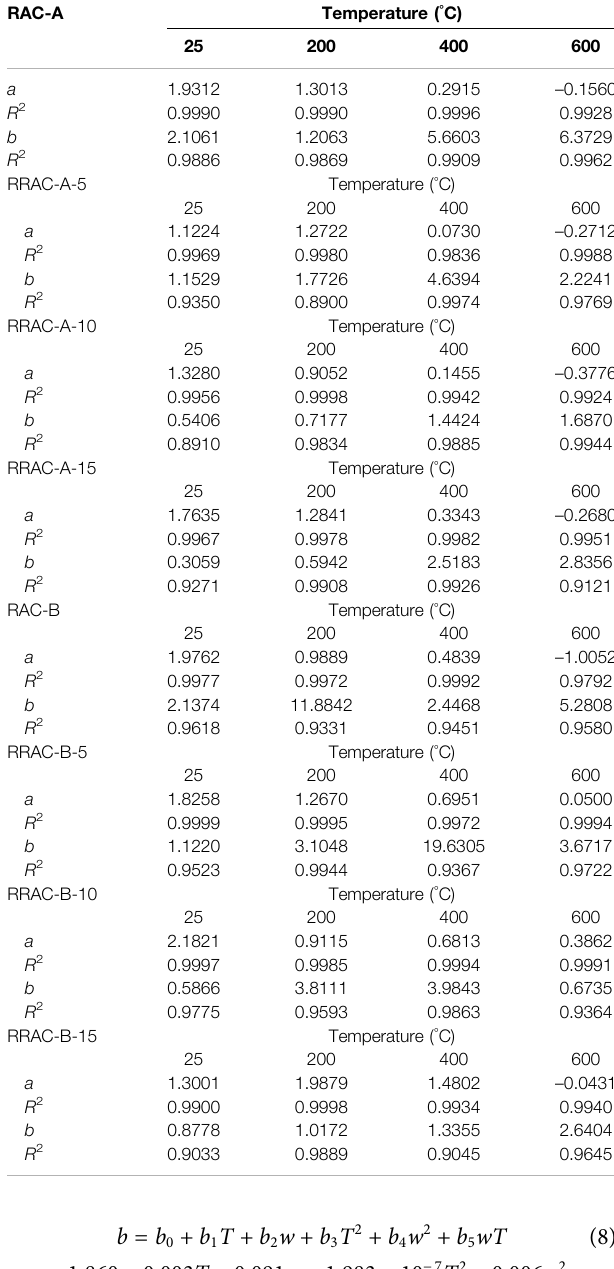
TABLE 10 | Parameters fi tting of the constitutive model for